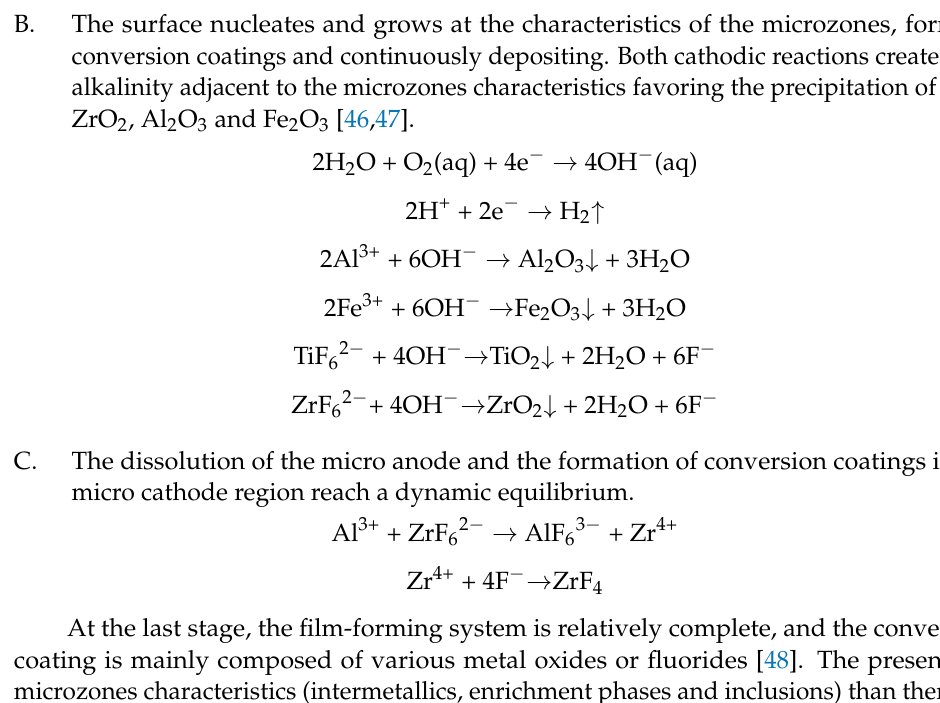
Figure 11. Schematic representations showing the evolution of the synchronous chemical conver- sion coatings on 6061 aluminum alloy/7075 aluminum alloy/galvanized steel. coatings on 6061 aluminum alloy/7075 aluminum alloy/galvanized